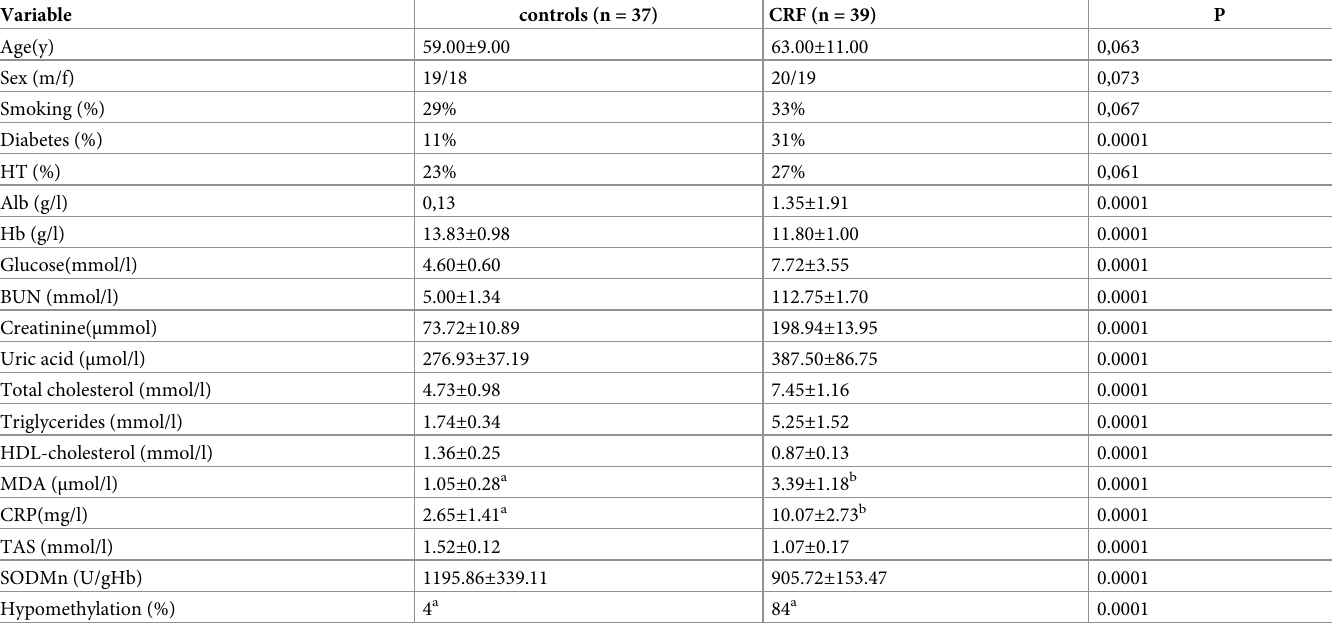
Table 1. Clinical characteristics, renal function, inflammatory and oxidative stress biomarkers and DNA p66shc methylation markers in CRF and controls